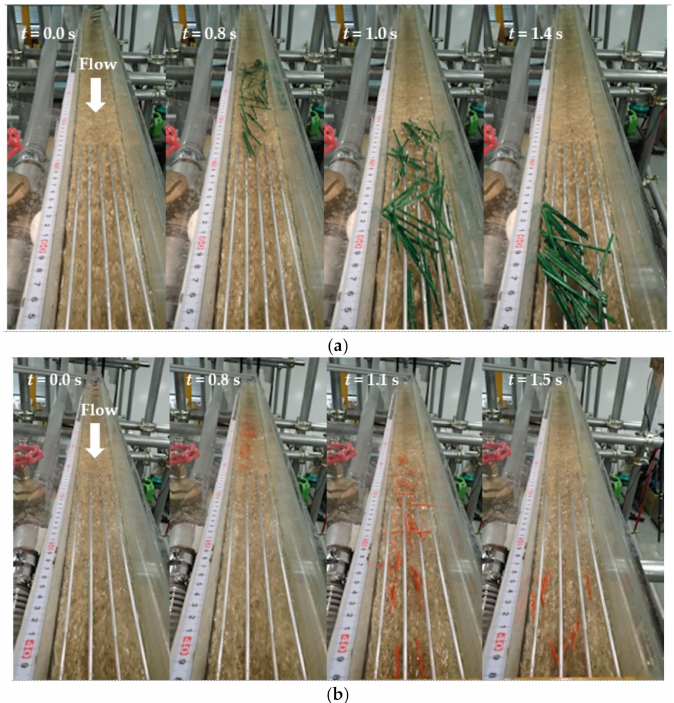
Figure 8. ( a ) LW captured by the traps (5 rods, n = 50, L w = 8 cm, and r w = 180 s − 1 ); ( b ) LW not captured (4 rods, n = 50, L w = 4 cm, and r w = 180 s − 1